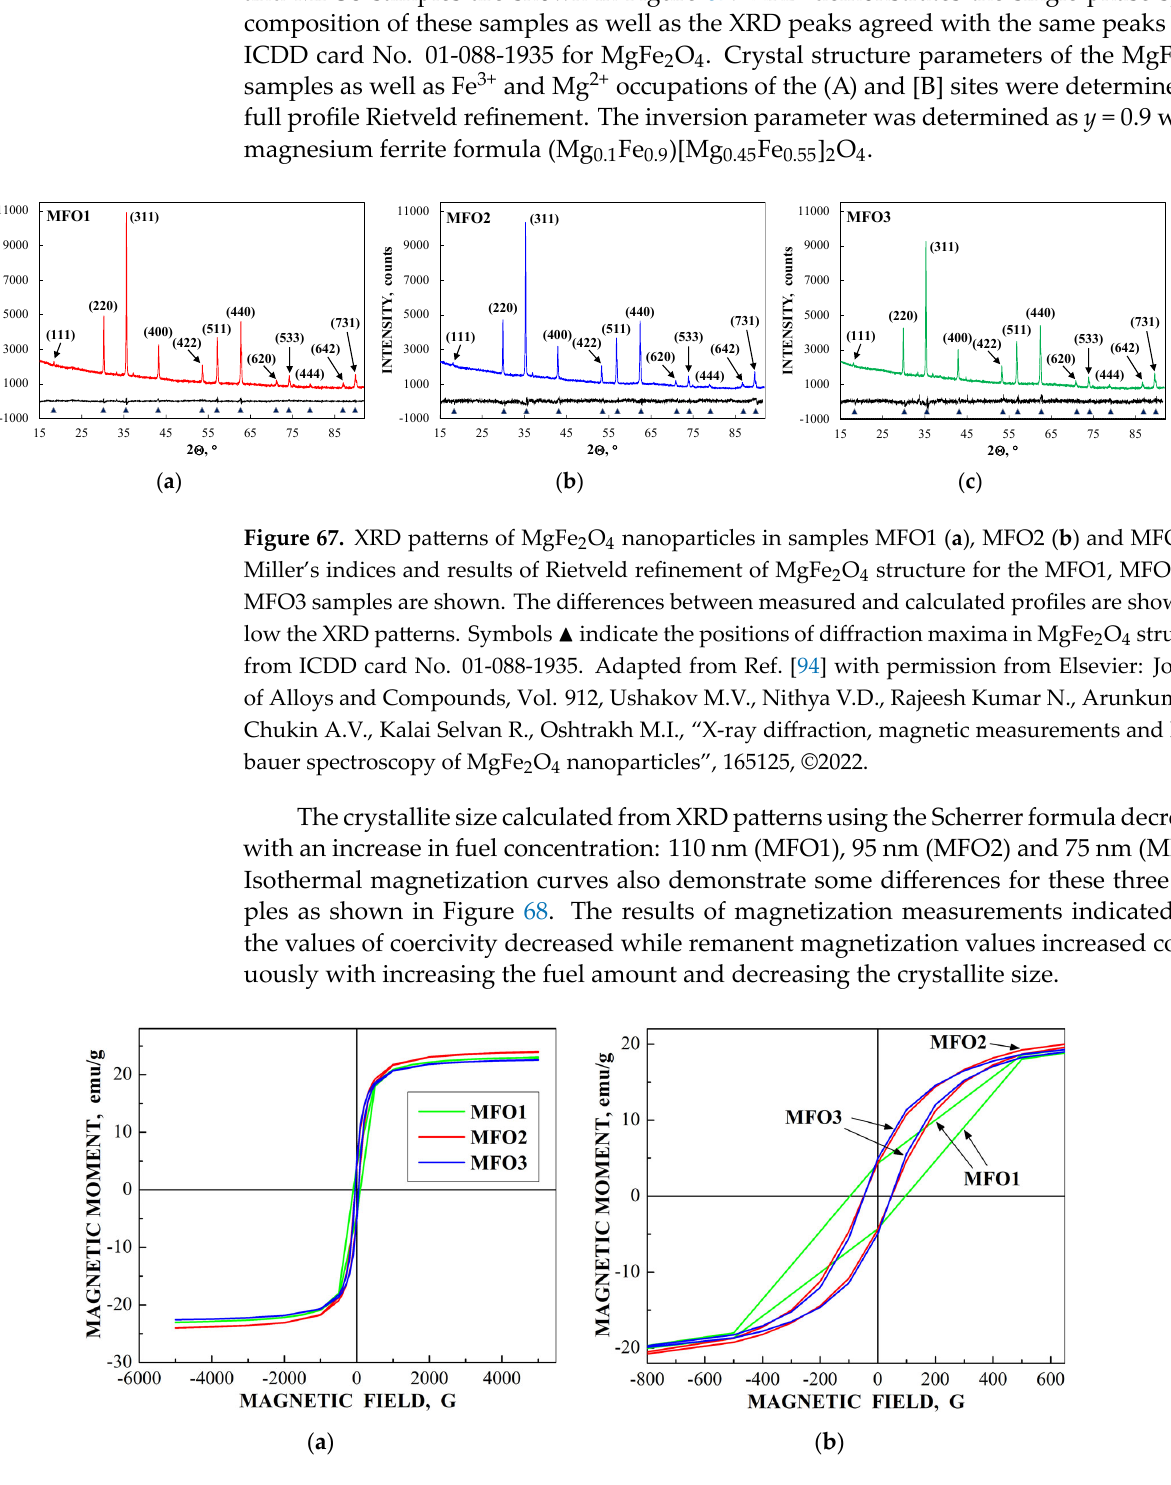
Figure 66. SEM images of MgFe 2 O 4 particles in samples MFO1 ( a ), MFO2 ( b ) and MFO3 ( c ). Adapted from Ref. [94] with permission from Elsevier: Journal of Alloys and Compounds, Vol. 912,